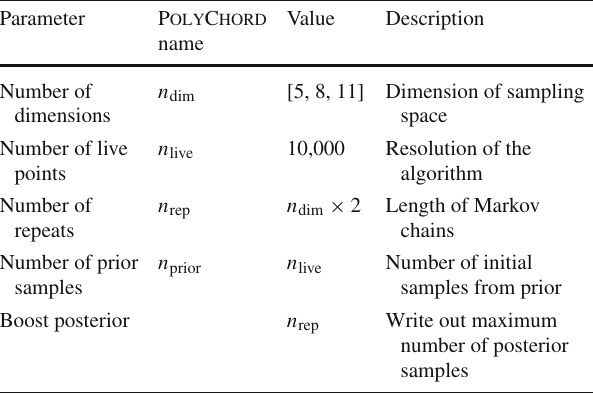
Table 3 PolyChord hyperparameters used for this analysis, parame- ters not listed follow the PolyChord defaults